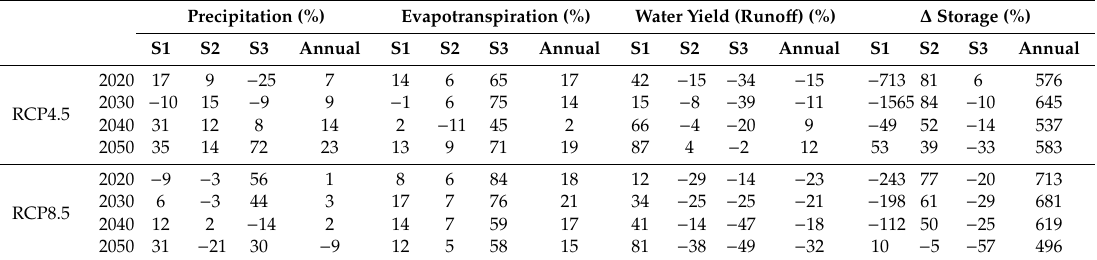
Table 6. Combined impacts of climate change and land use / cover change on hydrology considering baseline data of 2010. S1 is pre-monsoon season (March–May); S2 is monsoon season (June–September); and S3 is post-monsoon season